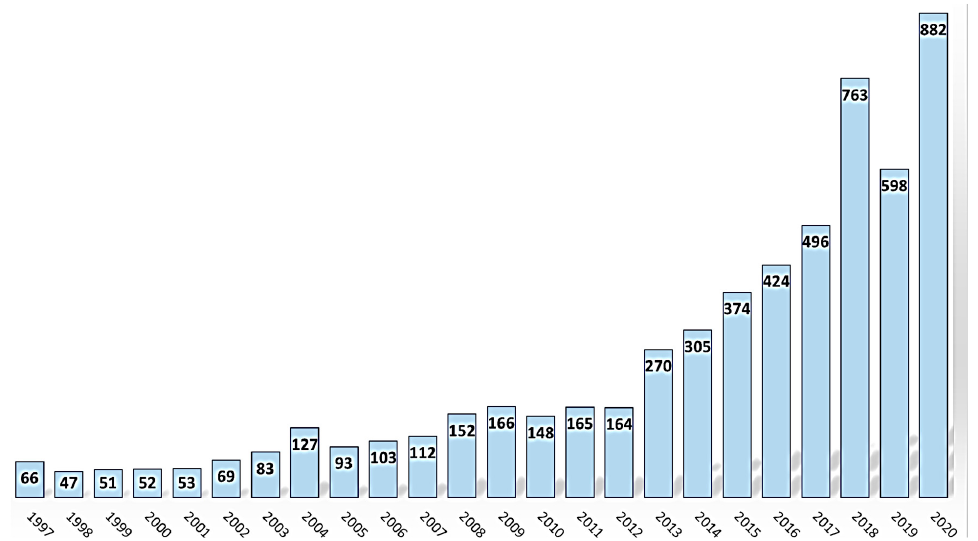
Figure 10. Evolution of the number of scientific papers related to the WEDM process in the ScienceDirect database.